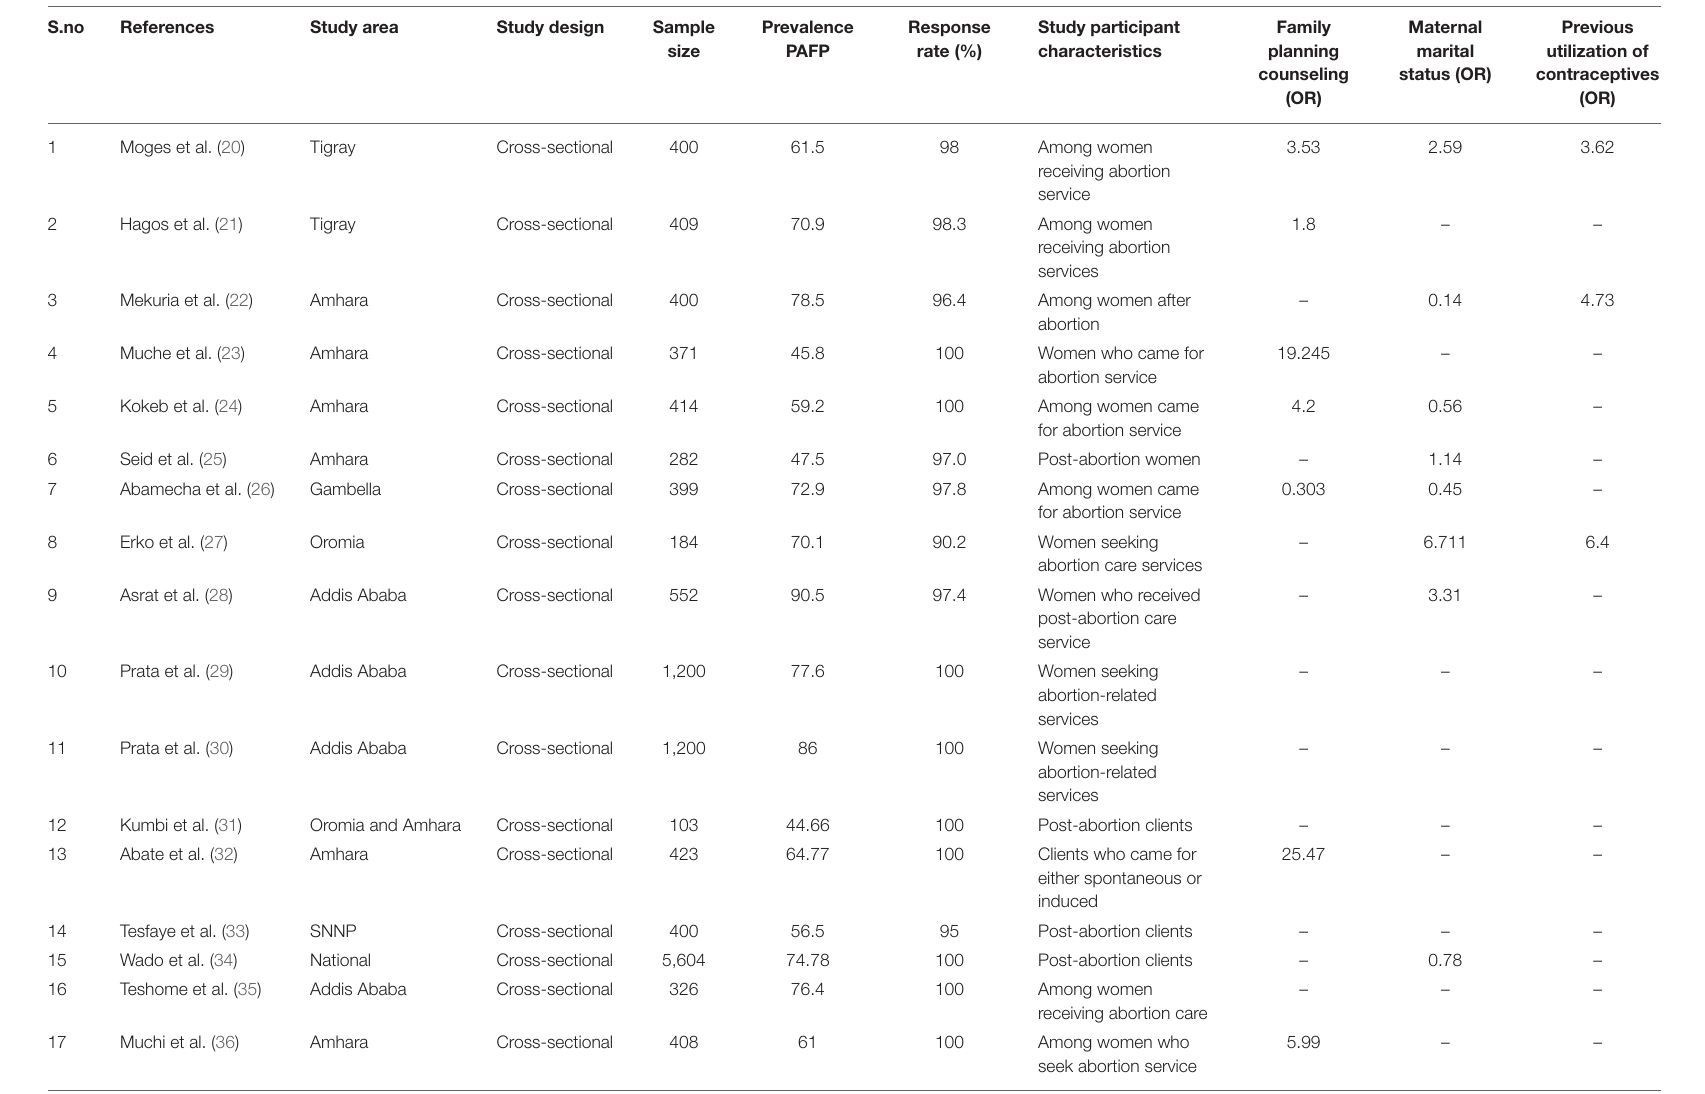
TABLE 1 | Descriptive summary of 17 studies included in the meta-analysis of the prevalence of post-abortion contraceptive utilization in Ethiopia.